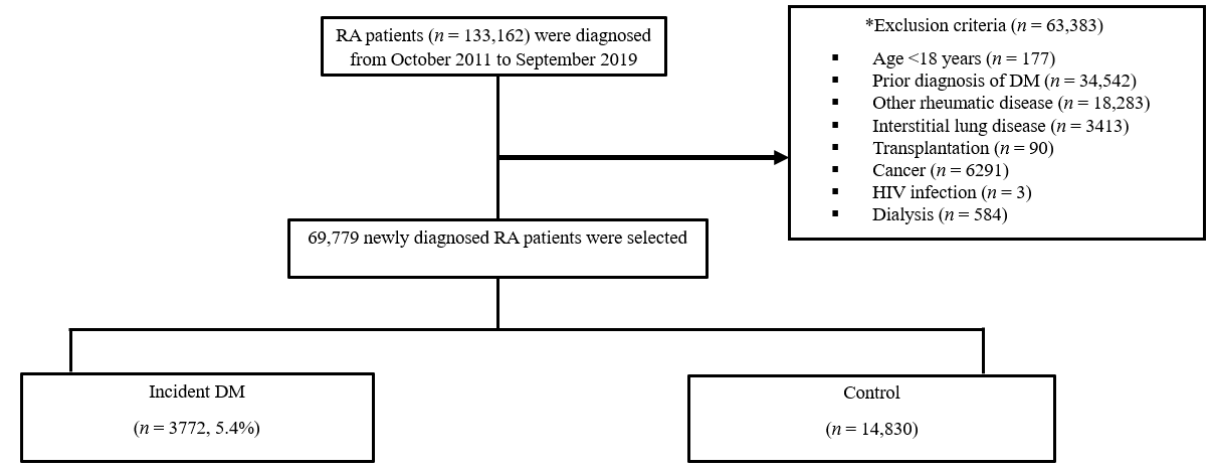
Figure 1. Flow diagram showing the selection illustration. RA: rheumatoid arthritis, DM: diabetes mellitus, HIV: human immunodeficiency virus * Other rheumatic disease were systemic lupus erythematosus and mixed connective tissue disease, Sjogren’s syndrome, and inflammatory myositis.